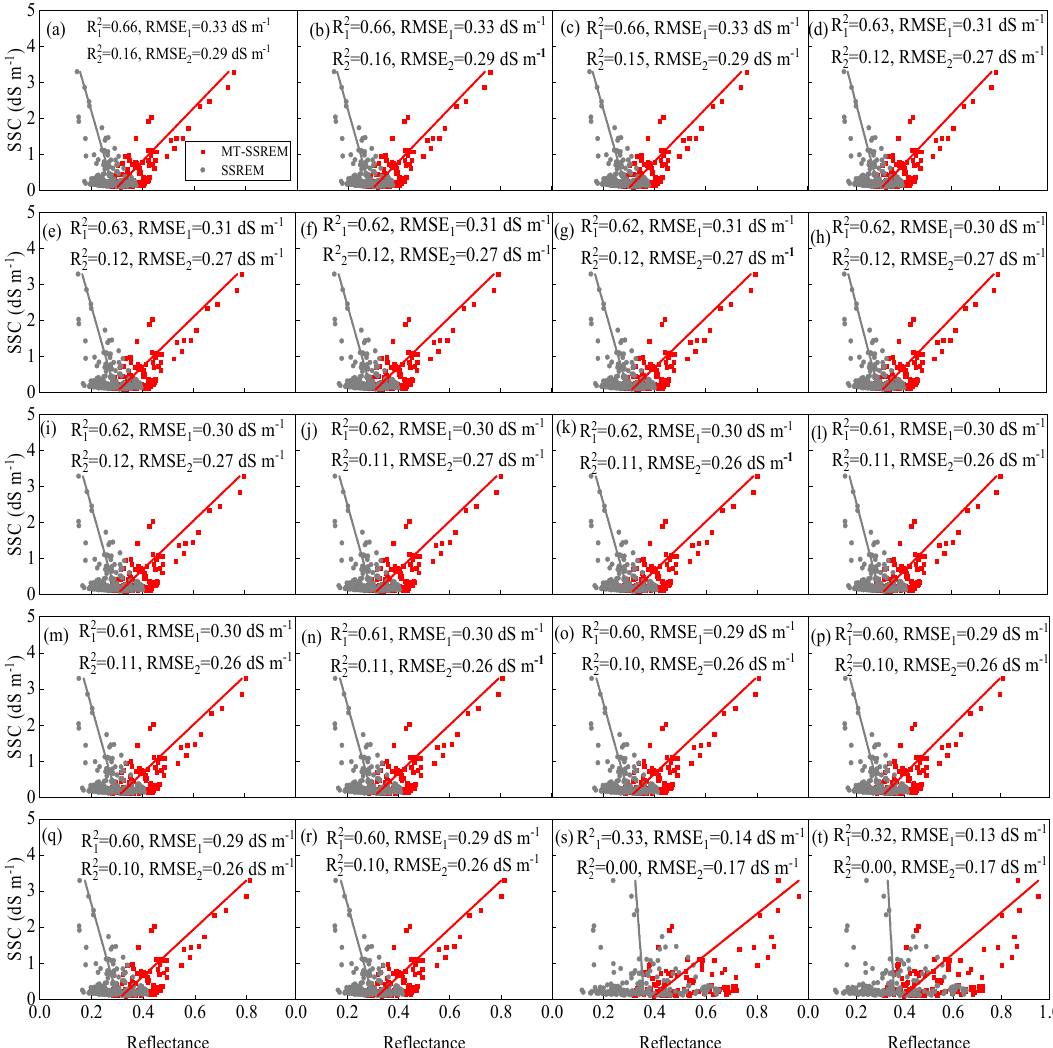
Figure 12. Performance of suggested bands to estimate SSC based on MT-SSREM and SSREM. ( a − t ) 658~660, 672~685, 938, 939 and 961 nm.